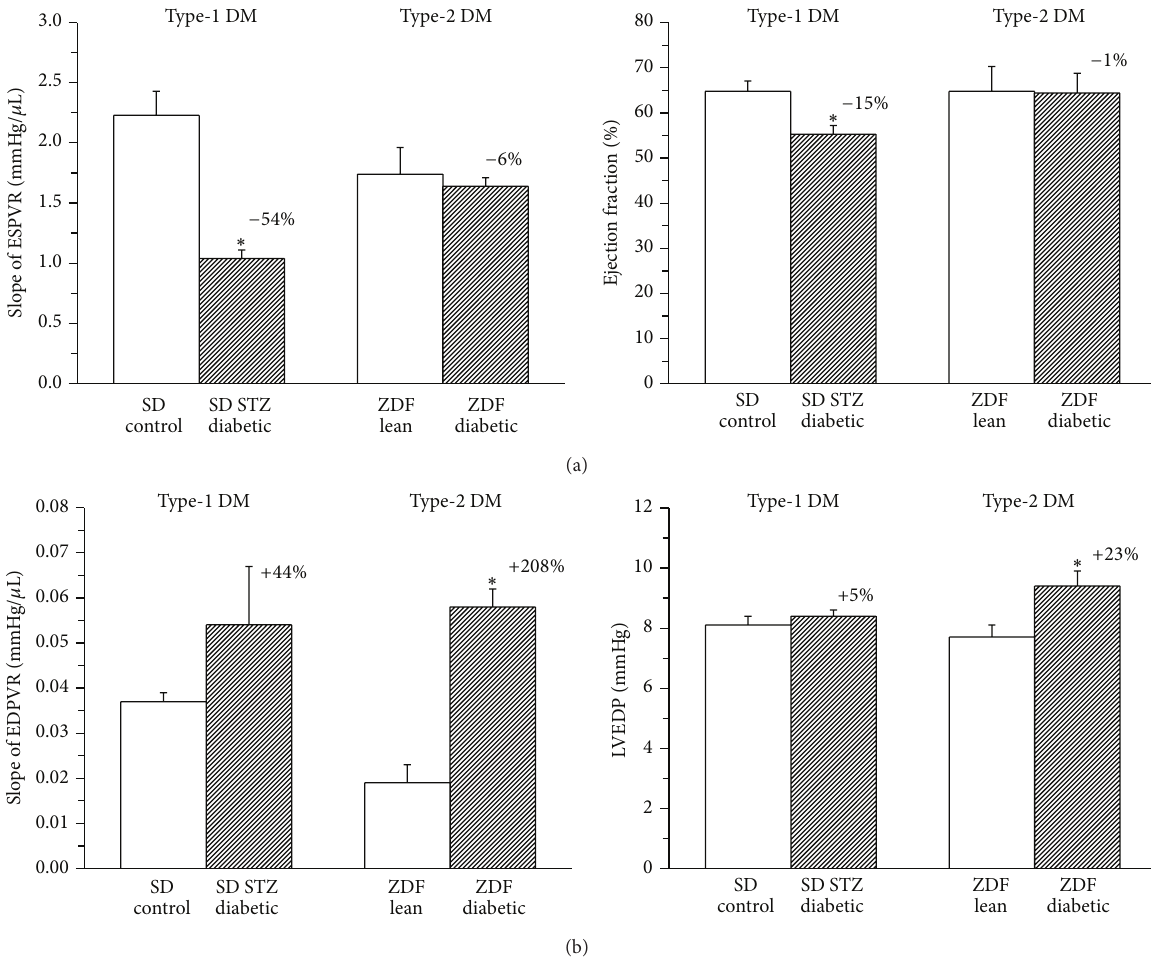
Figure 1: Different characteristics of cardiac dysfunction in type-1 and type-2 diabetes mellitus (DM) models. Left ventricular contractility indices (a): slope of end systolic pressure-volume relationship (ESPVR) and ejection fraction (EF) in the groups of SD control, STZ-induced diabetic SD, ZDF lean and ZDF diabetic rats. Parameters of left ventricular stiffness (b): slope of end-diastolic pressure-volume relationship (EDPVR) and end-diastolic pressure (LVEDP) in the groups of SD control, STZ-induced diabetic SD, Zucker Diabetic Fatty (ZDF) lean and ZDF diabetic rats. Bar graphs represent mean ± SEM. Percent changes between diabetic and corresponding nondiabetic control groups are indicated in both DM models. ∗ : 𝑃 < 0.05 versus the corresponding nondiabetic